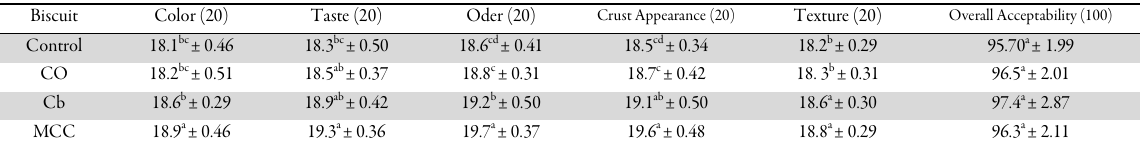
Table 8. Sensory evaluation of colored wheat flour biscuit made using different levels of cocoa and chocolate brown powder